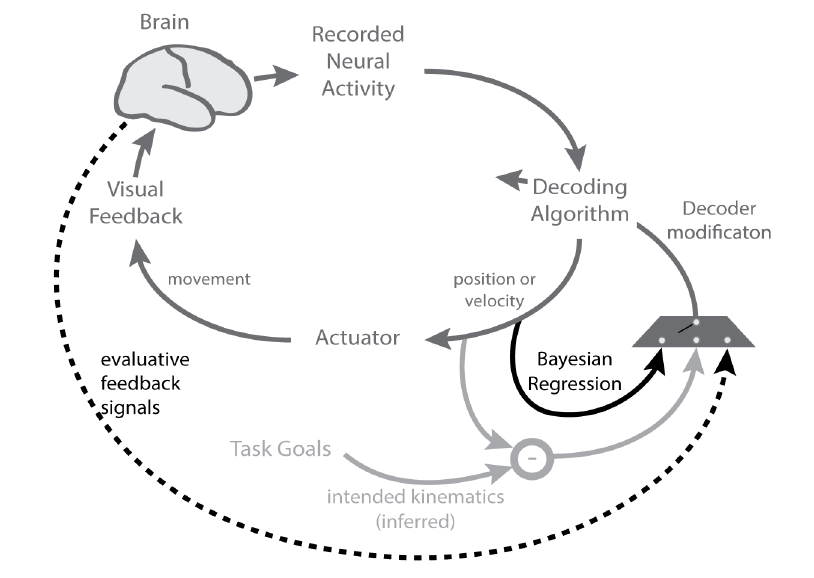
Figure 1. Closed-loop decoder adaptation (CLDA) accelerates learning and improves performance by updating a BMI decoder’s parameters in closed-loop operation (i.e., while the subject is using the BMI). The gray arrows point to the main elements of a closed- loop BMI: sensing (neural activity), estimation (decoding algorithm or transform), control of the actuator, and feedback. The red arrows represent the CLDA component. BMI errors are analyzed online with respect to inferred or known task goals, and/or on evaluative feedback. These errors are used to modify the decoder’s parameters. Overall, CLDA improves BMI performance by making the decoder more accurately represent the true underlying mapping between the user’s neural activity and their intended movements (adapted from [30] with permission).